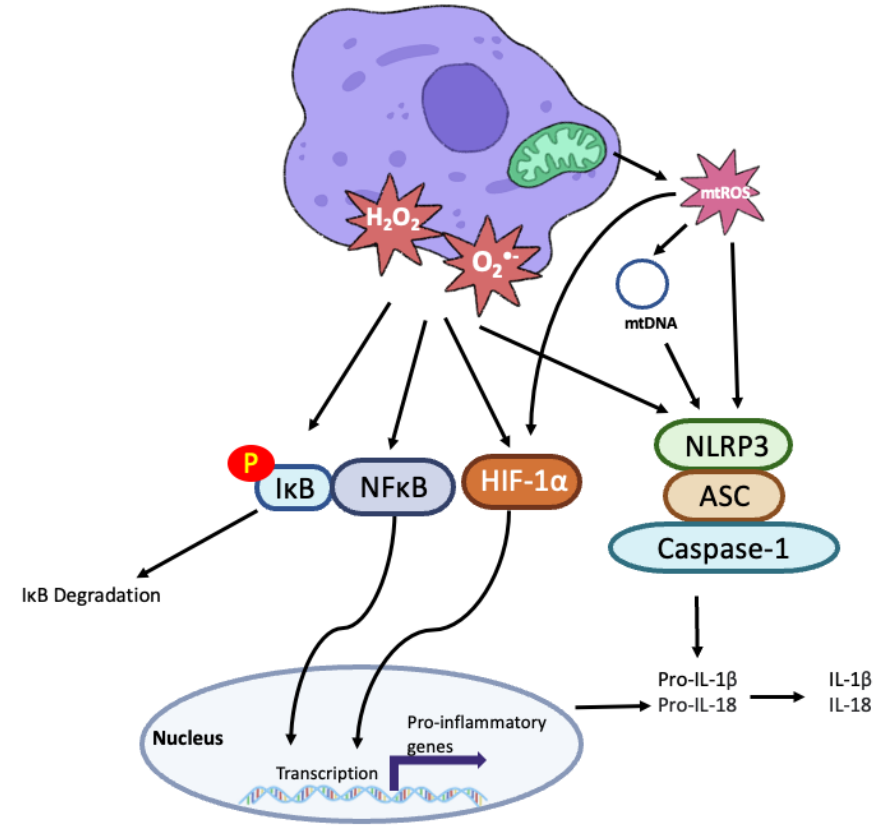
Figure 3. Overview of ROS in Vascular Inflammation.